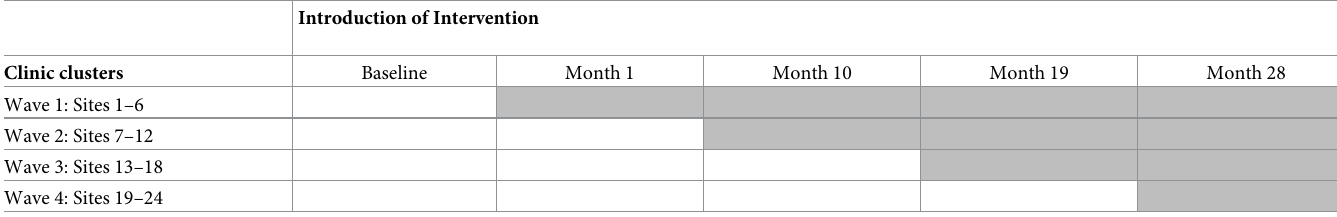
Table 1. Overview of stepped-wedge trial timing, by cluster